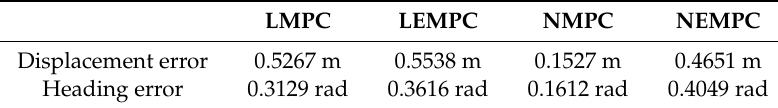
Table 6. The maximum absolute values after weight